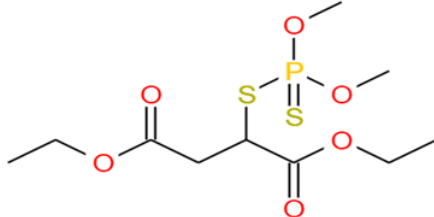
Figure 1. Structural formula of malathion.